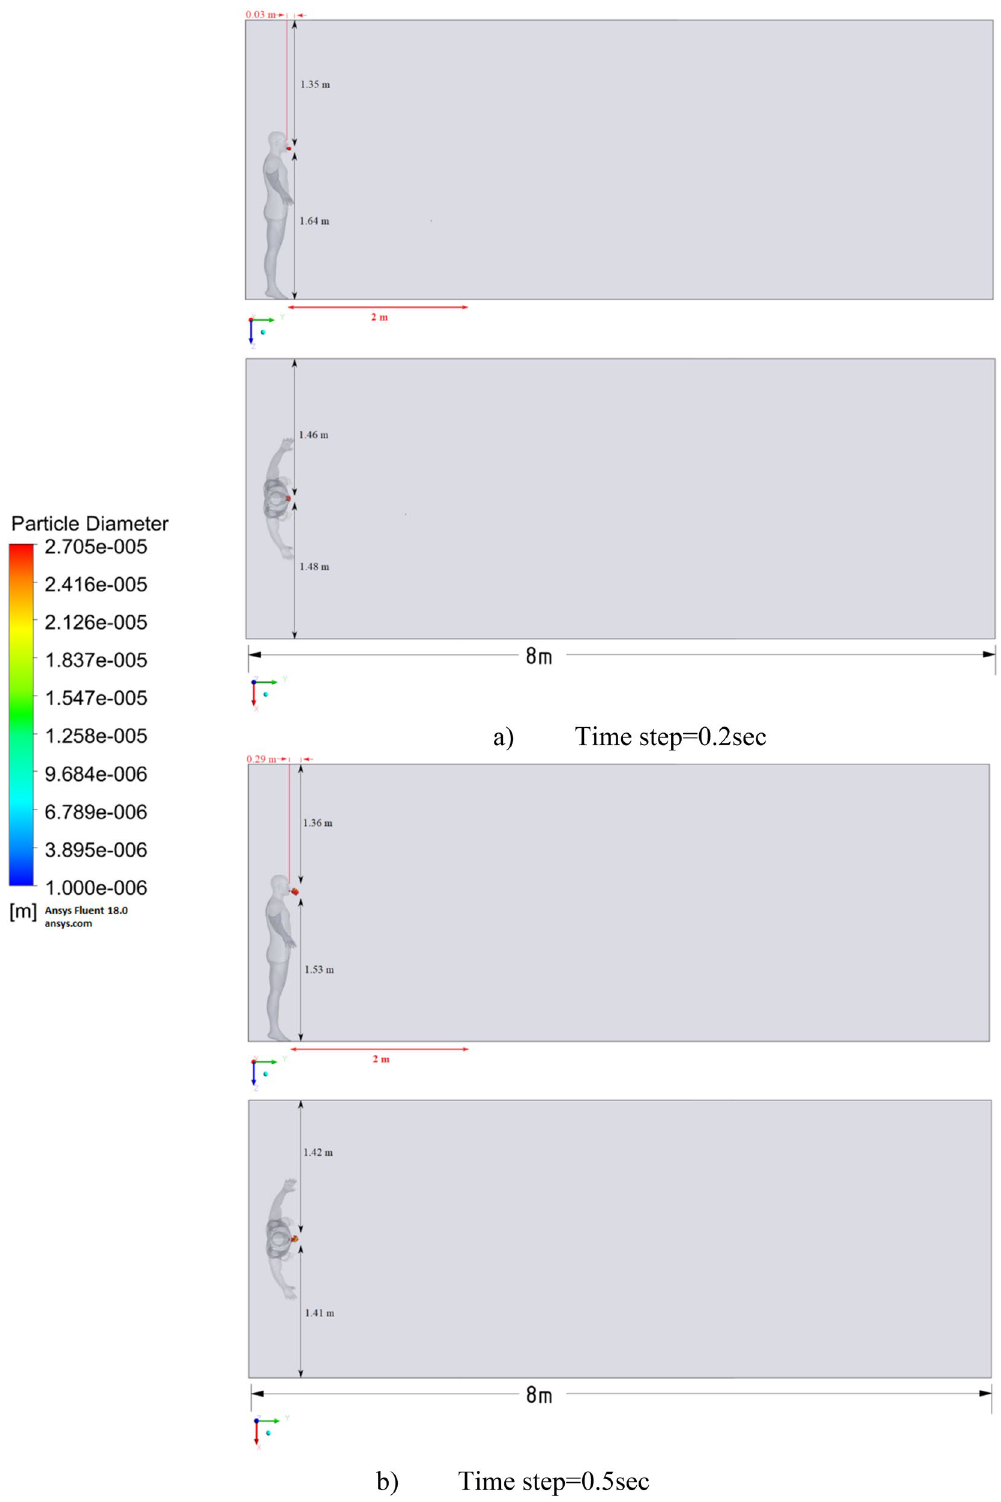
Figure 9. Distribution of the particles for cough = 1 m/s without